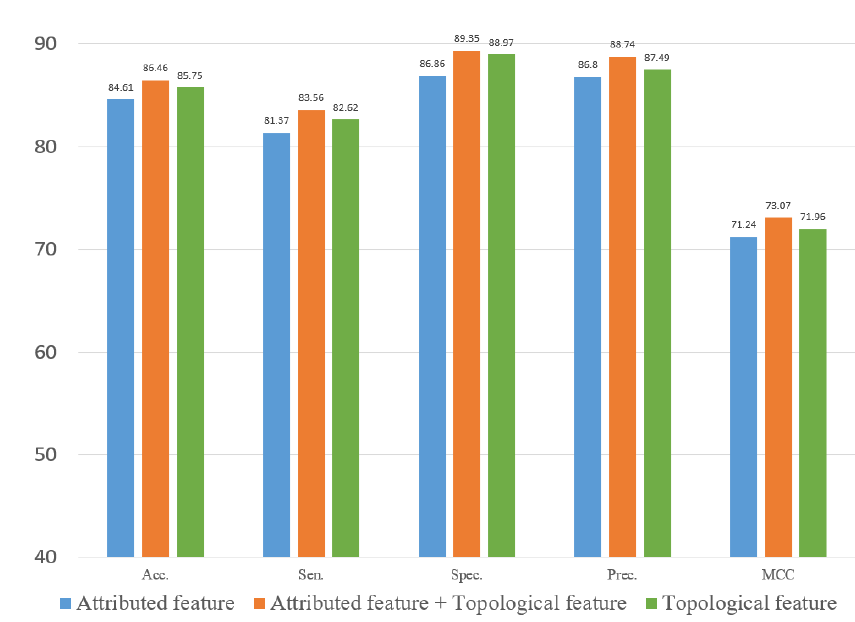
Figure 10. Result of ablation experiment on the ncDR dataset.